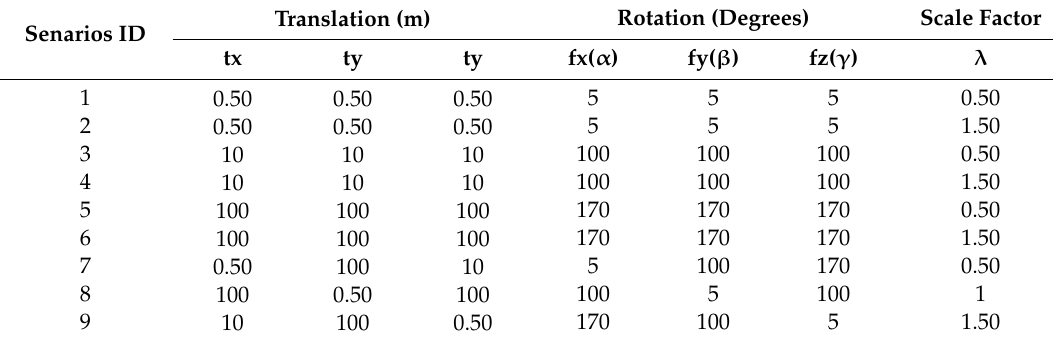
Table 1. Scenarios for each dataset, which were tested for each calculation method. Senarios